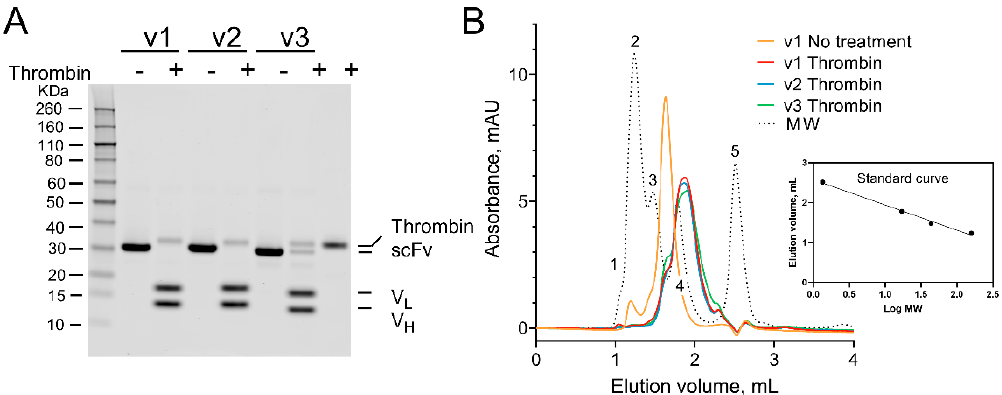
Figure 3. Cleavage of iKM33 variants by thrombin. The scFv variants were incubated with thrombin for 10 min at 37 °C. The samples of iKM33-v1 (v1), iKM33-v2 (v2), and iKM33-v3 (v3) were treated with 0.05 µg of thrombin per 1 µg of protein substrate. The reactions were stopped by adding PPACK. The parental iKM33 (31 kDa) was found not to be cleavable in preliminary experiments. ( A ) The samples with (+) and without thrombin cleavage ( − ) were loaded on SDS-PAGE gels (3 µg protein per well), and the gel was stained by Coomassie blue. The bands of V H (~13 kDa) and V L (~17 kDa) were identified based on their theoretical molecular weight. ( B ) SE-FPLC analysis of the thrombin-cleaved samples. MW—elution profile of molecular weight markers: thyroglobulin bovine 670 kDa (1), γ -globulin bovine 158 kDa (2), ovalbumin chicken 44 kDa (3), myoglobin horse 17